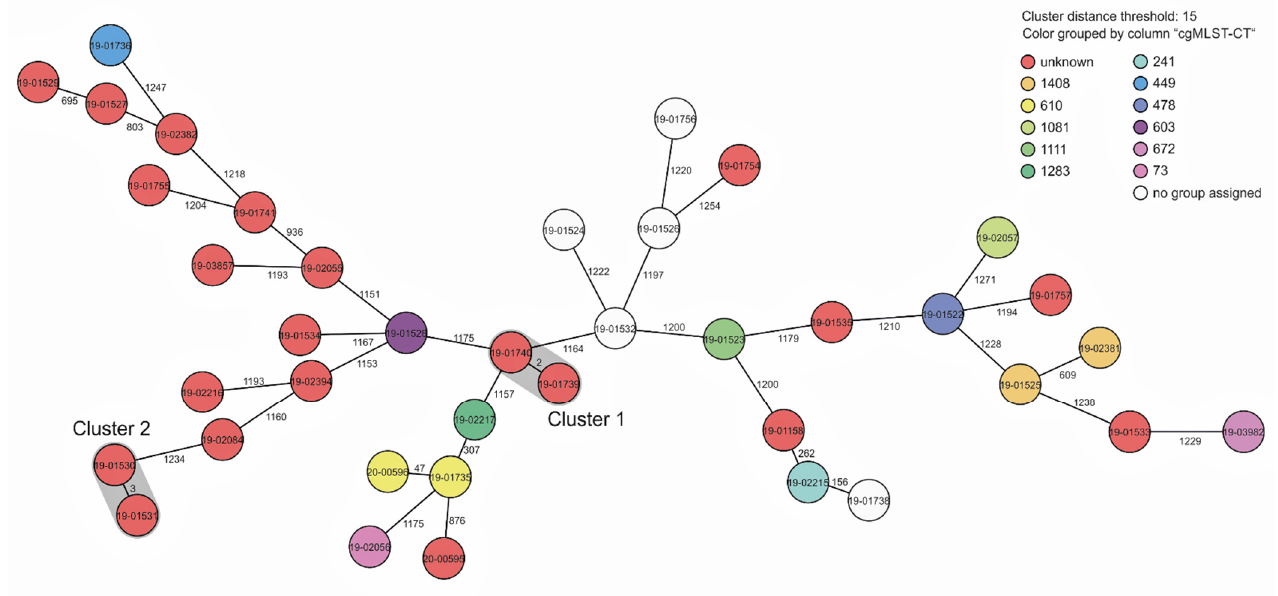
Figure 2. Minimum spanning tree based on core-genome multilocus sequence typing allelic profiles of 39 S. pseudintermedius isolates from humans and dogs in households (cohort I). Colors indicate the cgMLST-CT (as deduced from WGS data). Grey shades indicate clusters with <15 allelic differences between in the isolates. Table 5. Antibiotic resistance phenotypes of S. pseudintermedius from dogs in the cohorts.